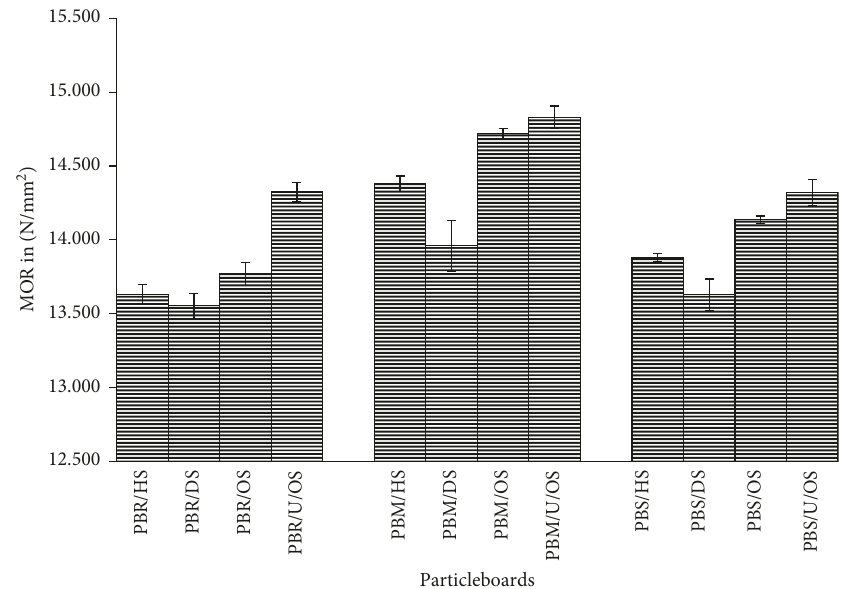
Figure 8: MOR of the three particleboards formulated in this